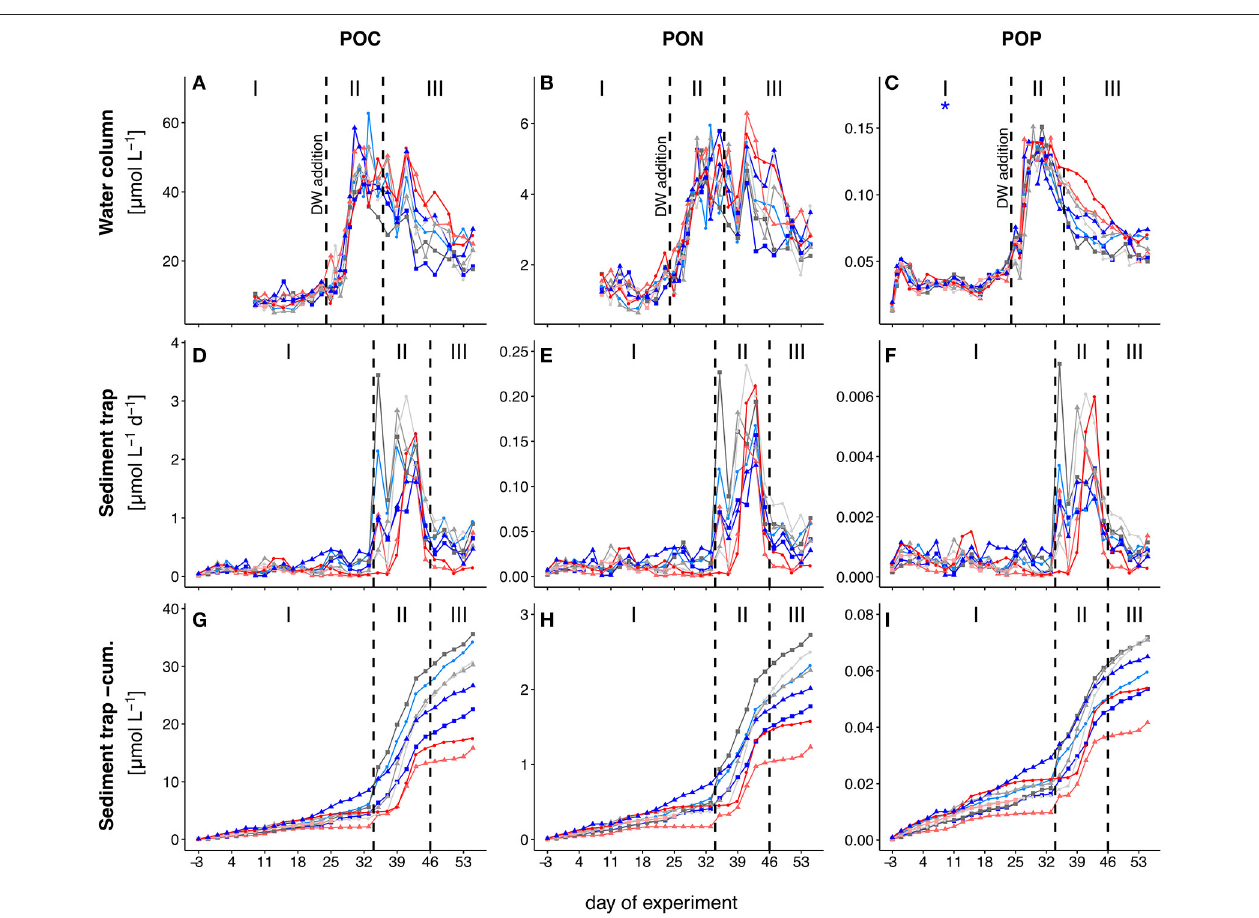
FIGURE 2 | Temporal development of standing stocks and fluxes of total particulate carbon (TPC; A,D , G ), nitrogen (TPN; B,E,H ) and phosphorus (TPP; C,F ,I ). (A–C) and (D–F) depict POM concentrations from the water column and daily flux to the sediment trap, respectively. (G–I) show the cumulative flux of POM to the sediment trap. Colored lines depict the different mesocosms. The three different phases are indicated with I, II, and III and separated by the dashed vertical lines. Note that the first dashed line in (A–C) also depicts the time of deep-water addition. Colors and symbols are described in Table 1 . The * denotes a statistically significant postitive (red) or negative (blue) effect of CO 2 during the respective experimental